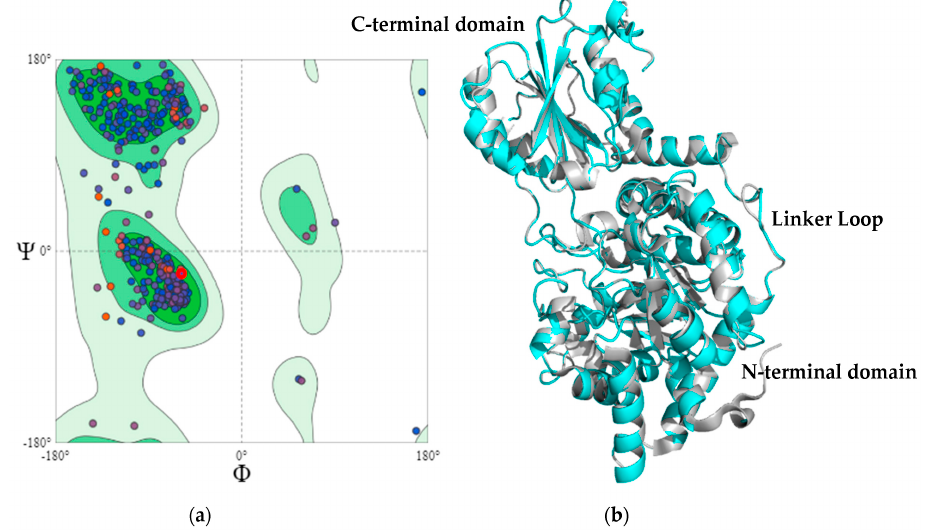
Figure 2. The model validation of MaBgl3 using ( a ) a Ramachandran plot and ( b ) a three-dimensional (3D) structure of MaBgl3 (cyan) in alignment with glycoside hydrolase from Synechococcus sp. PCC 7002 (gray).